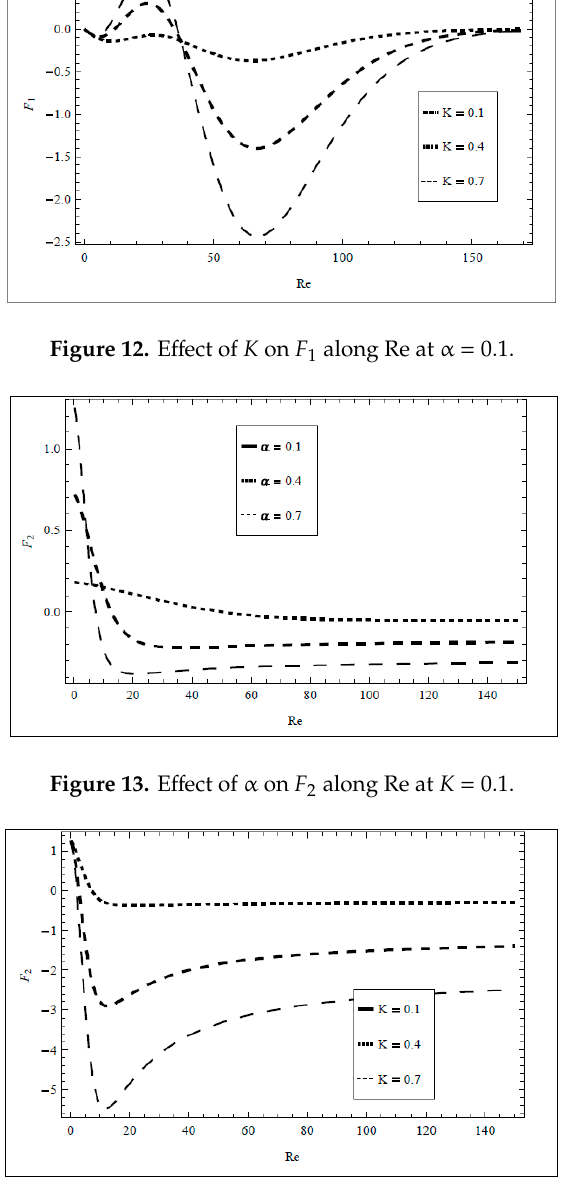
1 along Re at K